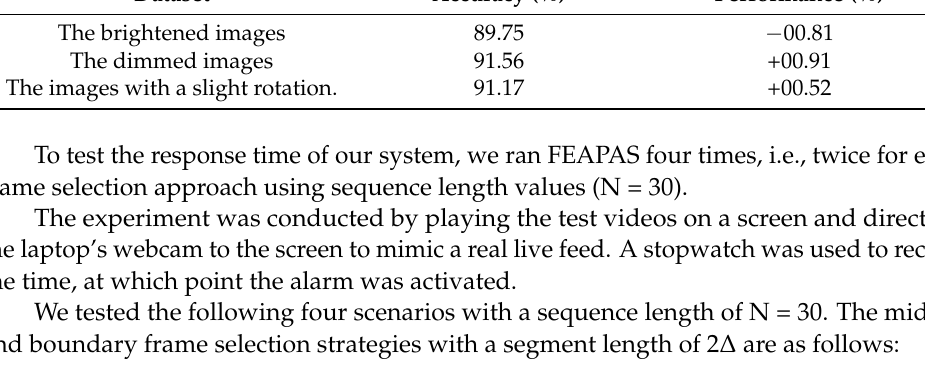
Table 6. The impact of brightness and head rotation on the InceptionV3_SGD model. Dataset Accuracy (%) Performance (%) The brightened images 89.75 − 00.81 The dimmed images 91.56 +00.91 The images with a slight rotation. 91.17 +00.52